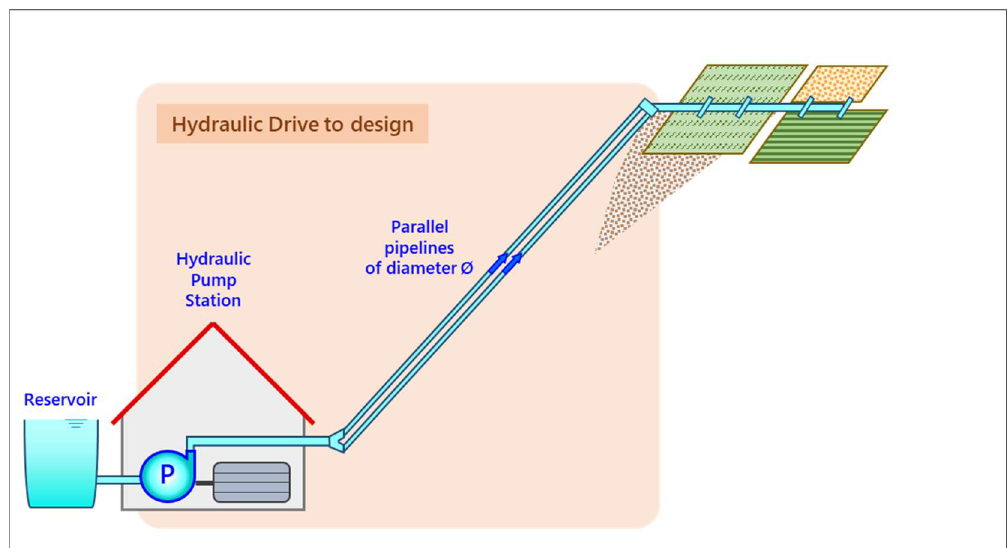
Figure 5. Case study scheme for application of the Equivalent Flow Rate concept. Table 1. Water demand in the study case.